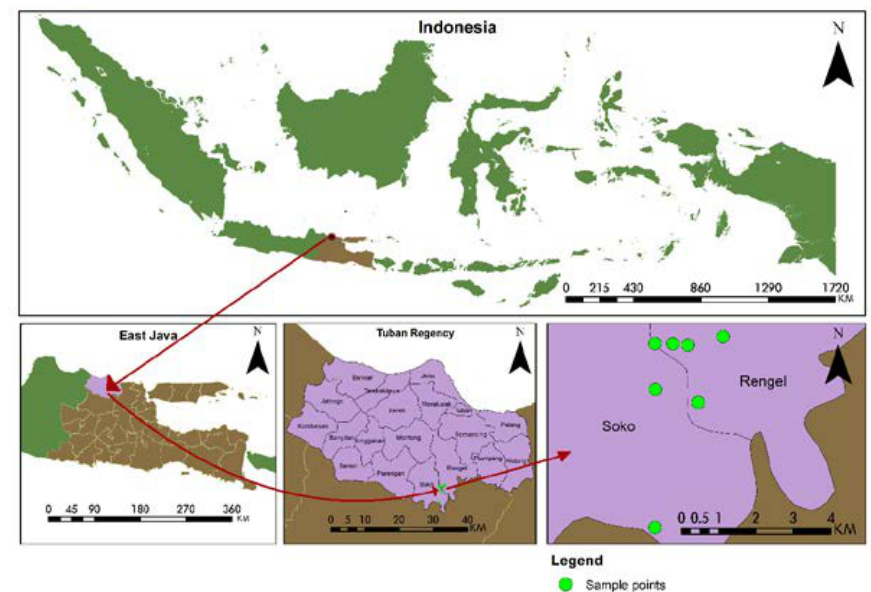
Fig. 1: Geographical location of the Cangkring River, Indonesia, along with the seven sampling points